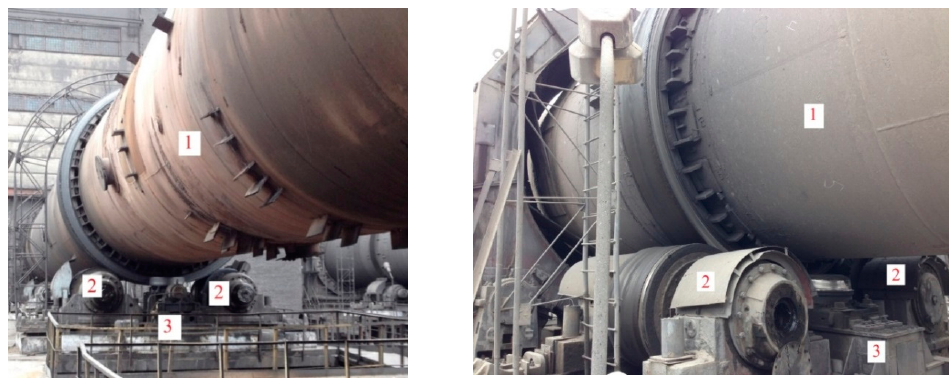
Figure 15. Rotary kiln on paired roller bearings . 1: kiln ; 2: roller bearings ; 3: support foundation.